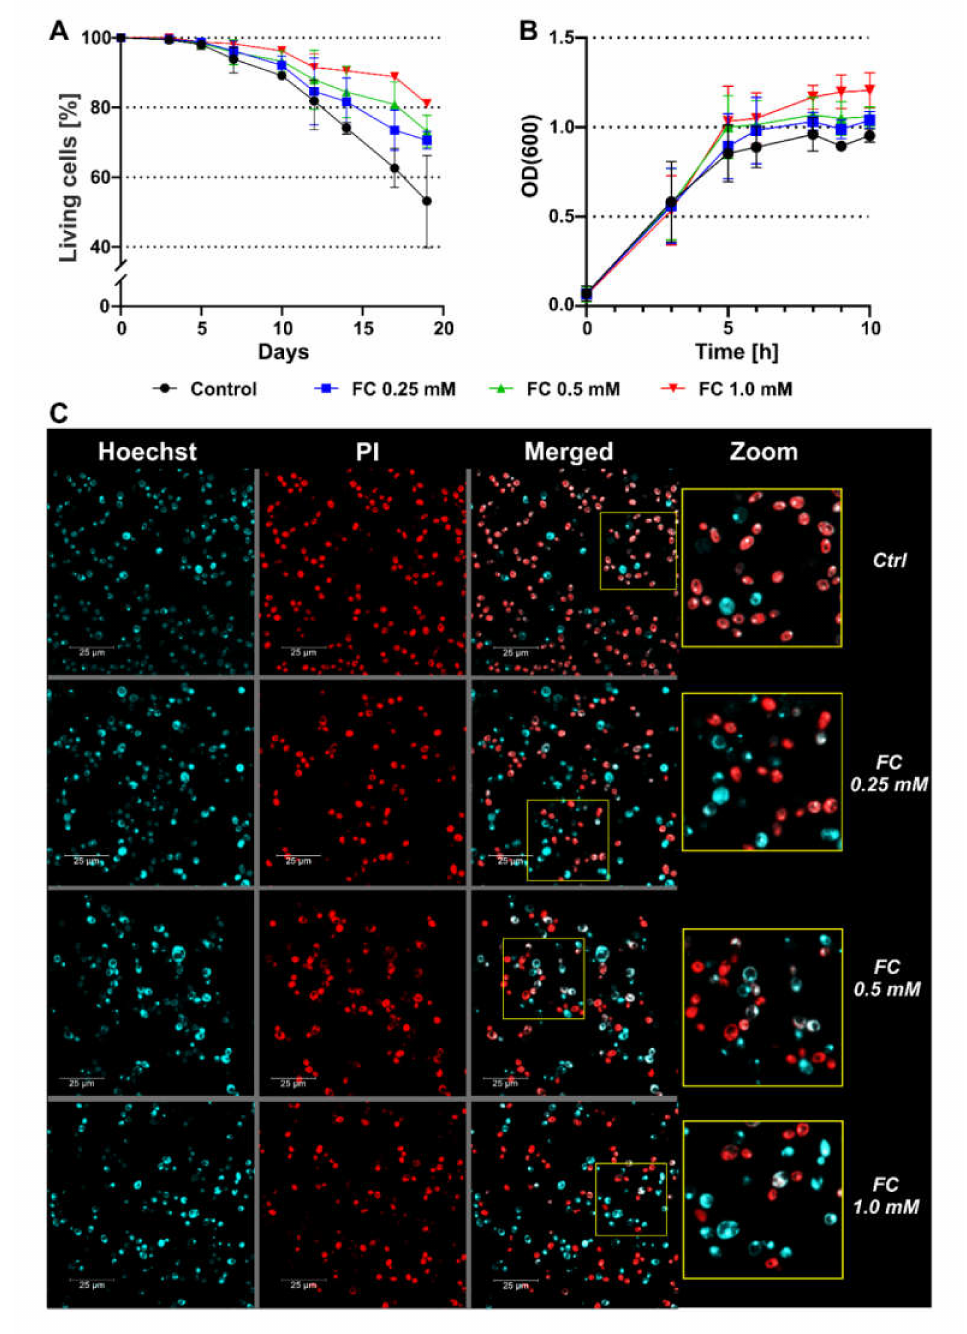
Figure 2. Effect of FC supplementation on the viability of BY474 yeast cells. ( A ) Yeast CLS in the presence of 0.25 (blue (cid:4) ), 0.5 (green (cid:78) ), or 1.0 (red (cid:72) ) mM FC, and in its absence (control, black • ), evaluated using flow cytometry using PI staining. Since PI enters dead cells, unstained cells were considered alive. Data are presented as the mean percentage of live cells within the total analyzed population (10,000 cells) ± SD of three independent experiments. ( B ) Growth kinetics of yeast in the exponential phase determined based on OD 600 measurements. Data are presented as mean ± SD of three independent experiments. ( C ) Confocal microscopy imaging of cells on day 14 of the CLS assay using Hoechst 33342 and PI staining. Blue (ex/em: 405/435–480 nm) and red (ex/em: 543/585–640 nm) fluorescence correspond to live and dead cells, respectively. Merged images are shown on the right